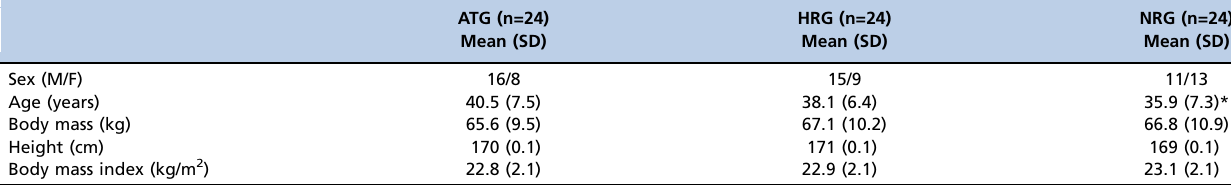
Table 1 - Baseline characteristics of the